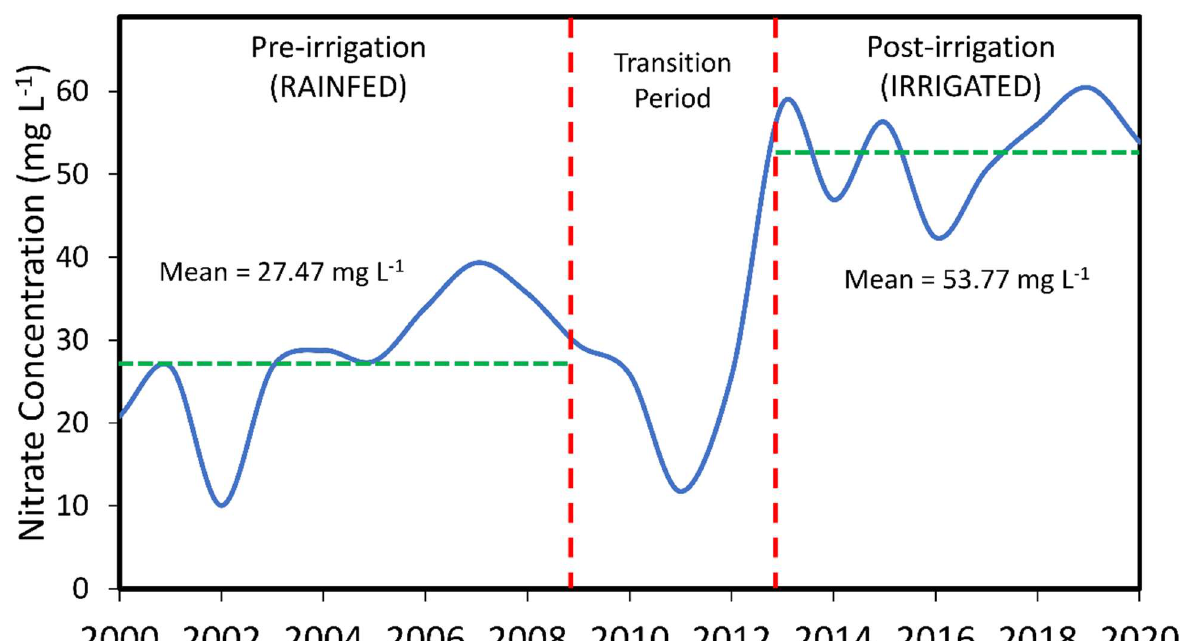
Figure 5. The average annual nitrate concentration distribution pattern at the watershed outlet in Traibuenas before and after irrigation implementation from 2000 to 2020.